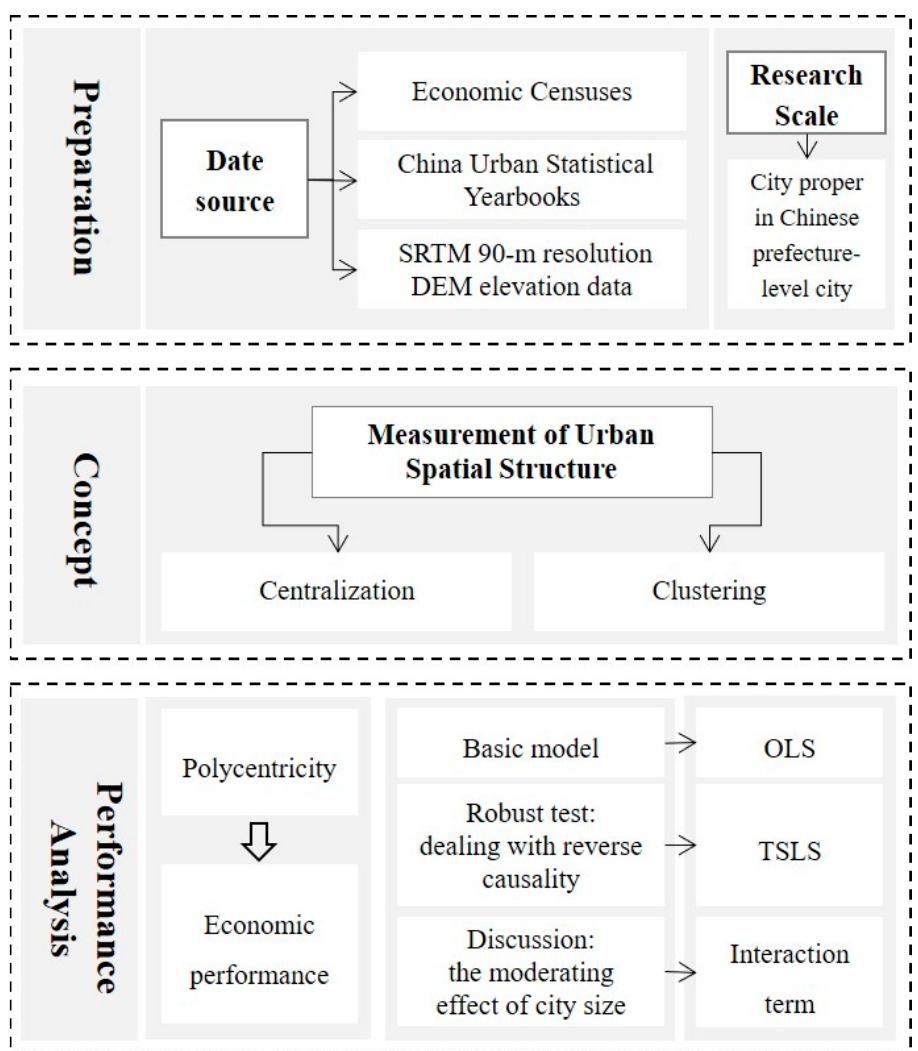
Figure 3. Methodological framework.